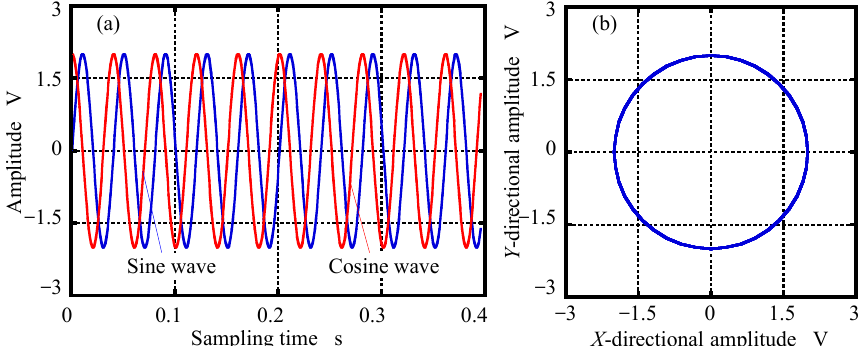
Figure 5. Corrected signals: ( a ) sinusoidal and cosine signals and ( b ) Lissajous figure. 4. Measurement Error Caused by the Stability of the LD Wavelength The unstable LD wavelength will affect the measurement accuracy of the MLDI. A